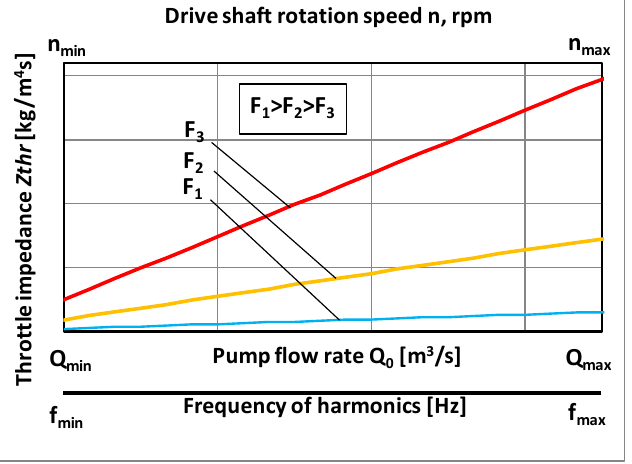
Figure 11. Throttle impedance.